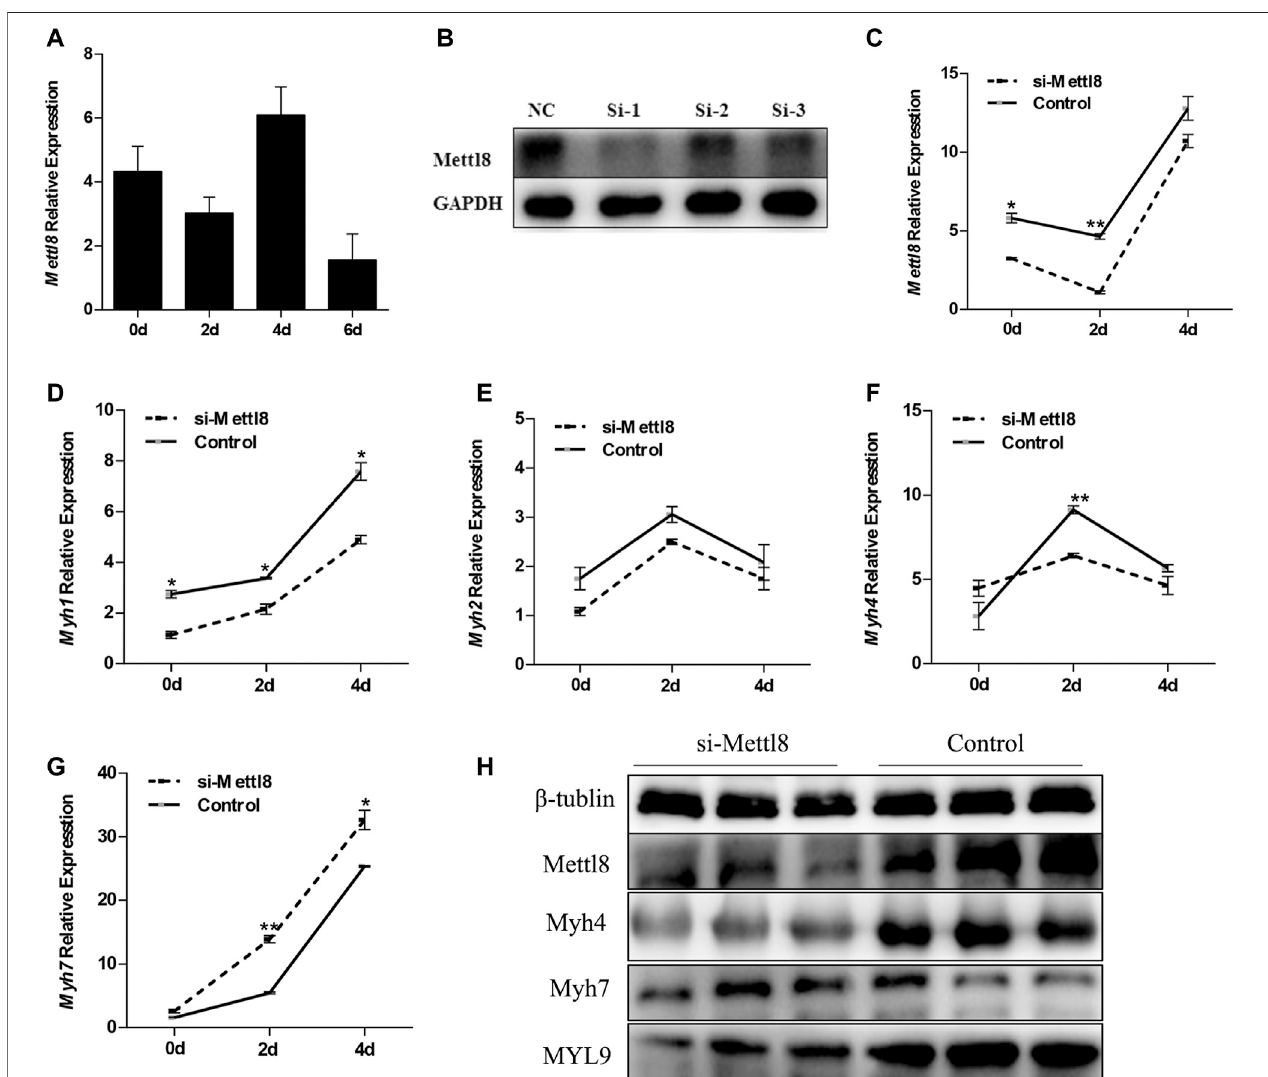
FIGURE5| Theeffect ofknockingdown Mettl8on MyHCexpression inC2C12 cellsduringmyogenicdifferentiation. (A) Theexpression ofMettl8 intheprocessof myogenicdifferentiationofC2C12 cells. (B) ThechangeofMettl8 protein expression levelafter transfection ofsiRNA, NC represents negativecontrol,si-1,si-2,andsi-3 represent the three designed Mettl8 interfering RNA. (C) Changes in Mettl8 mRNA expression after transfection of siRNA. (D – G) : Expression levels of Myh1 (D) , Myh2 (E) , Myh4 (F) , and Myh7 (G) in the endogenously Mettl8 knockdown C2C12 cells during the myogenic differentiation on days 0, 2, 4. (H) Protein expression levelsofMettl8,Myh4,Myh7,MYL9intheendogenouslyMettl8knockdownC2C12cells.si-Mettl8:C2C12cellstransfectedwith50 nMMettl8interferingRNAtoreduce the expression of endogenous Mettl8. Statistical comparisons are performed using ordinary one-way ANOVA in (A) and using multiple t -tests in (D – G) . * p < 0.05; ** p <